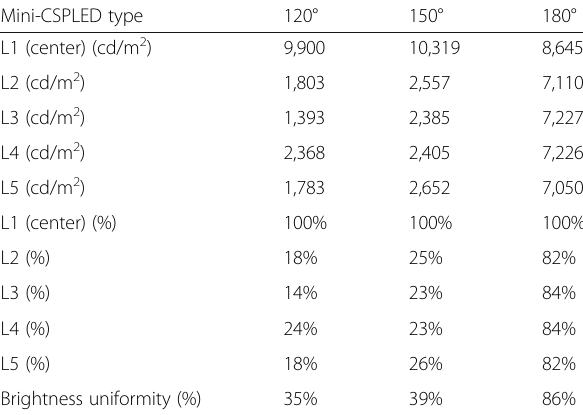
Table 5 Brightness uniformities of three kinds of mini-CSPLED BLUs with 150- μ m-thick QD films Mini-CSPLED type